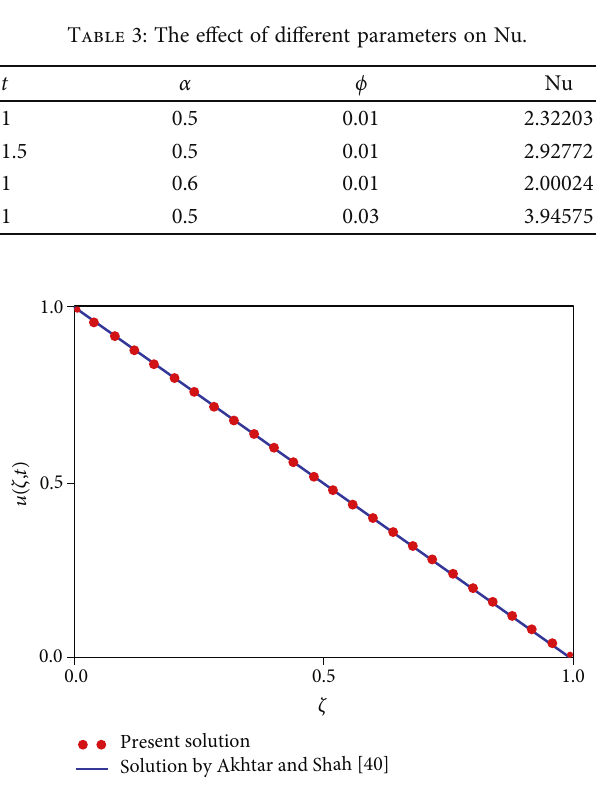
Figure 13: Comparison of the current solution with Akhtar and Shah [40].